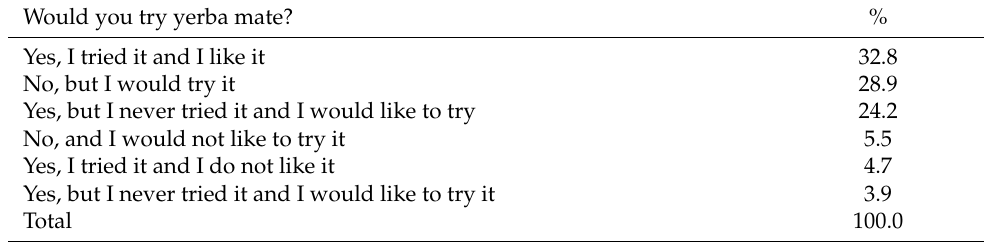
Table 3. Italian consumers’ perception of yerba mate properties and ways of consumption.